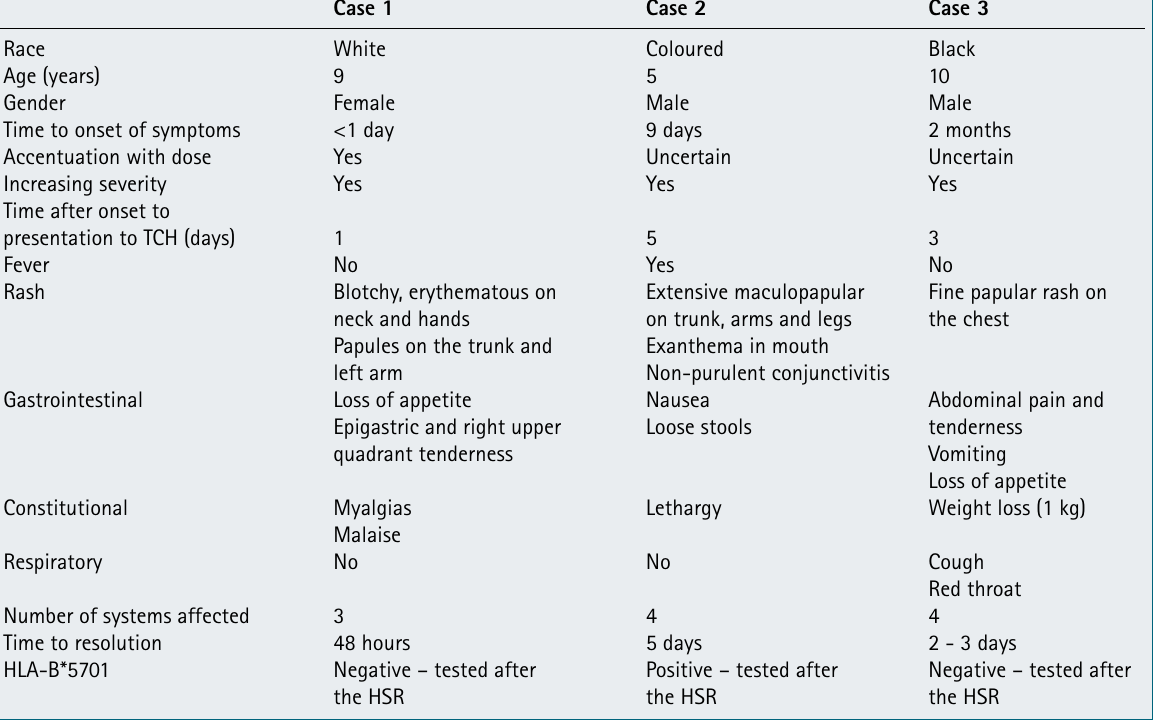
TABLE ii. CLiNiCAL FEATURES iN 3 CHiLDREN DiAGNOSED WiTH ABC HSR AT TYGERBERG CHiLDREN’S HOSPiTAL AFTER A SiNGLE DRUG SUBSTiTUTiON OF STAVUDiNE FOR LiPO-ATROPHY